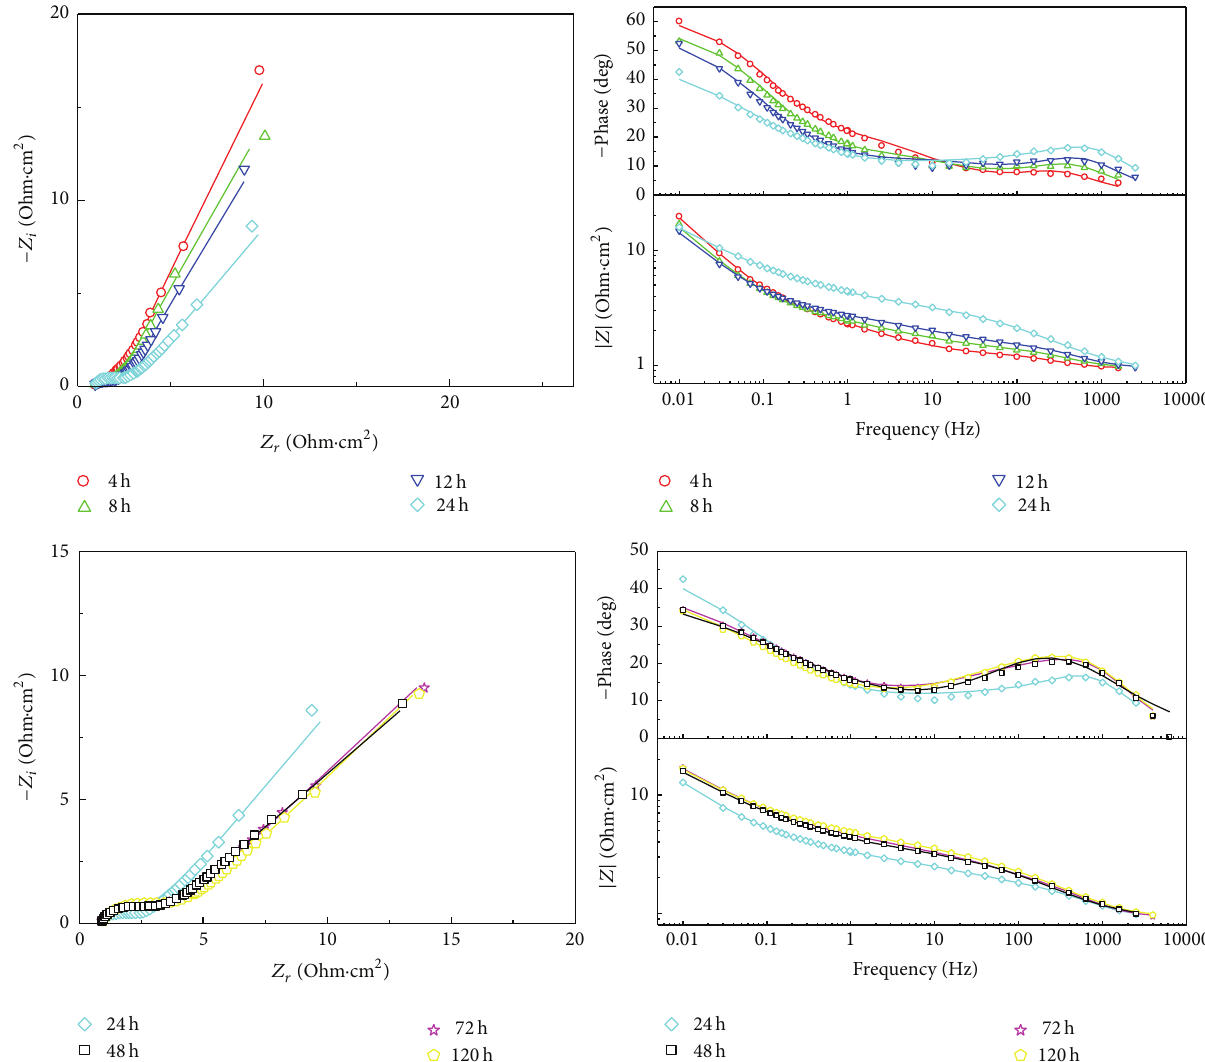
Figure 2: Nyquist and Bode plots of SS304 in molten carbonate at 650 ∘ C in air. Scattered points are measured data and lines are simulated